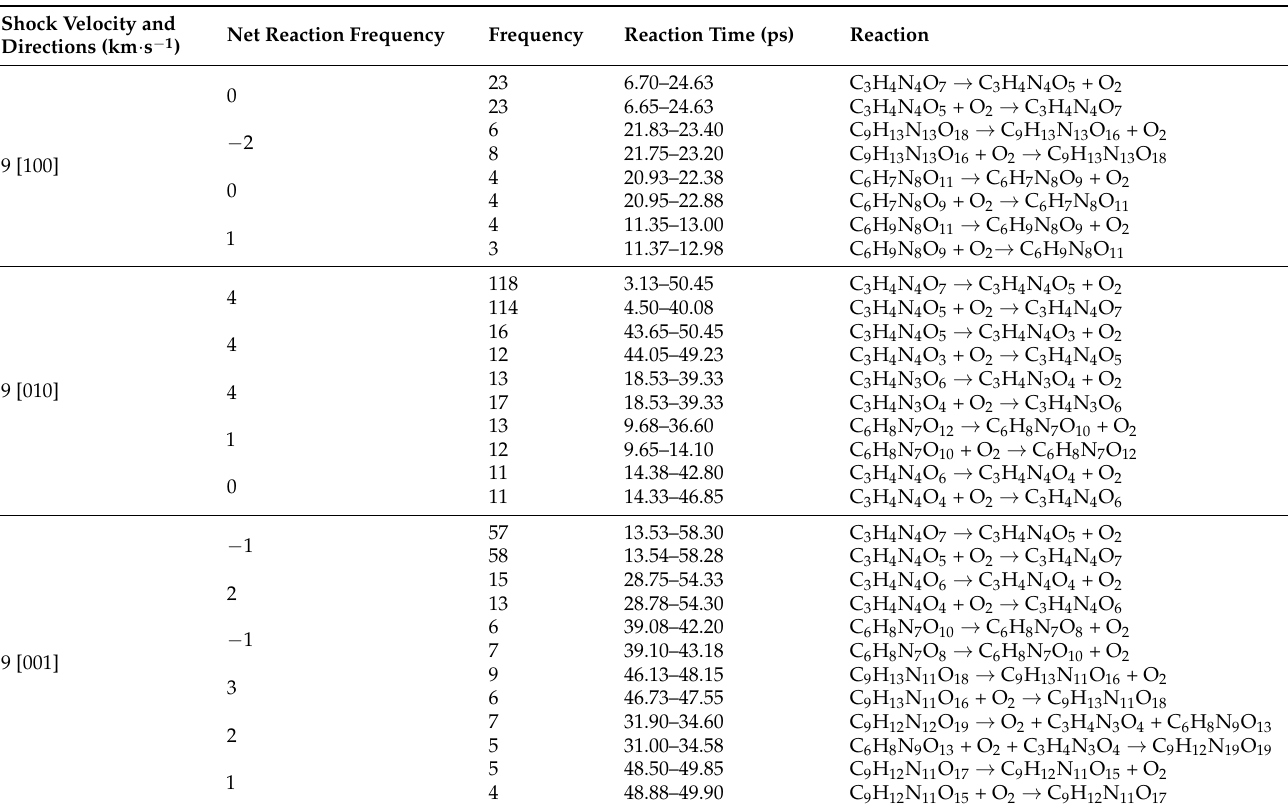
Table 5. Reactions of O 2 molecule